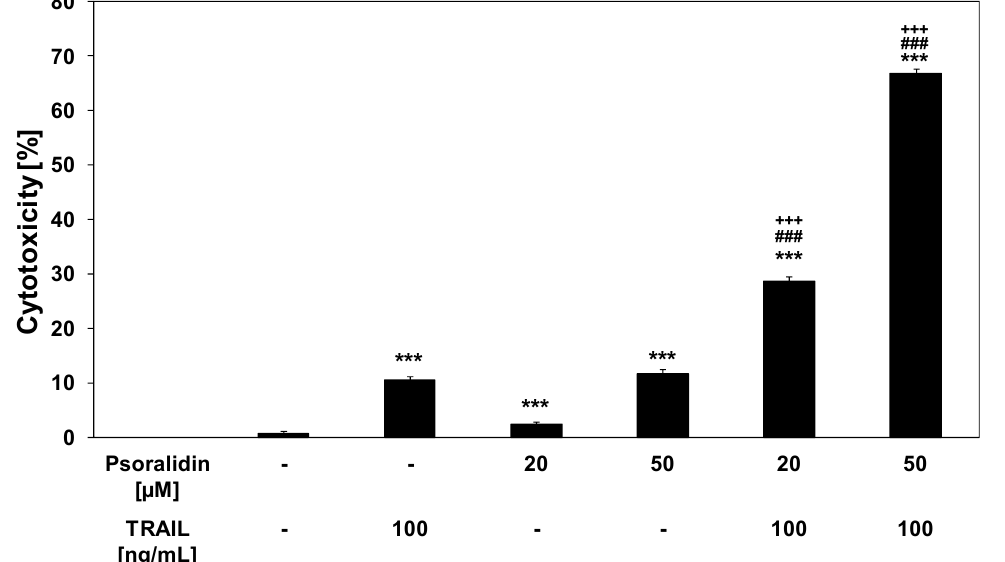
Figure 4. Cytotoxic activity of TRAIL in combination with psoralidin in HeLa cancer cells. The cancer cells were incubated for 48 h with TRAIL at the concentration of 100 ng/mL and psoralidin at the concentrations of 20 μ M and 50 μ M. The percentage of cell deaths was measured by MTT cytotoxicity assay. The values represent mean ± SD of three independent experiments performed in quadruplicate (n = 3) ( *** p < 0.001 compared with control, ### p < 0.001 compared with psoralidin and +++ p < 0.001 compared with